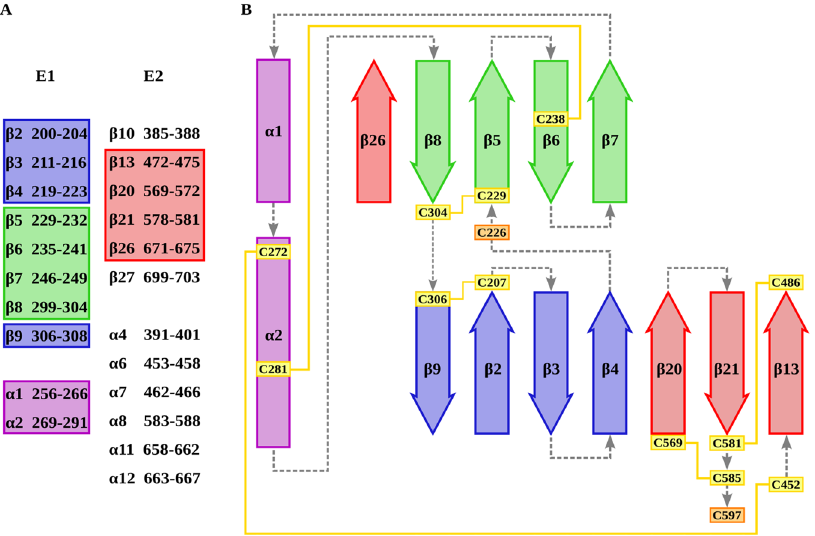
Figure 3. Secondary and tertiary structure prediction. In ( A ) all newly identified secondary structures in E1 and E2 are reported. (B ) Secondary, tertiary and quaternary arrangement of E1 and E1E2 interfaces. In both panels, previously characterized domains are omitted. Strands and helices, respectively represented as arrows and rectangles, follow the same color scheme in both panels. Successive secondary structure elements are connected by dashed gray lines. Cysteines involved in disulfide bonds are boxed in yellow and connected by yellow lines, free cysteines are boxed in